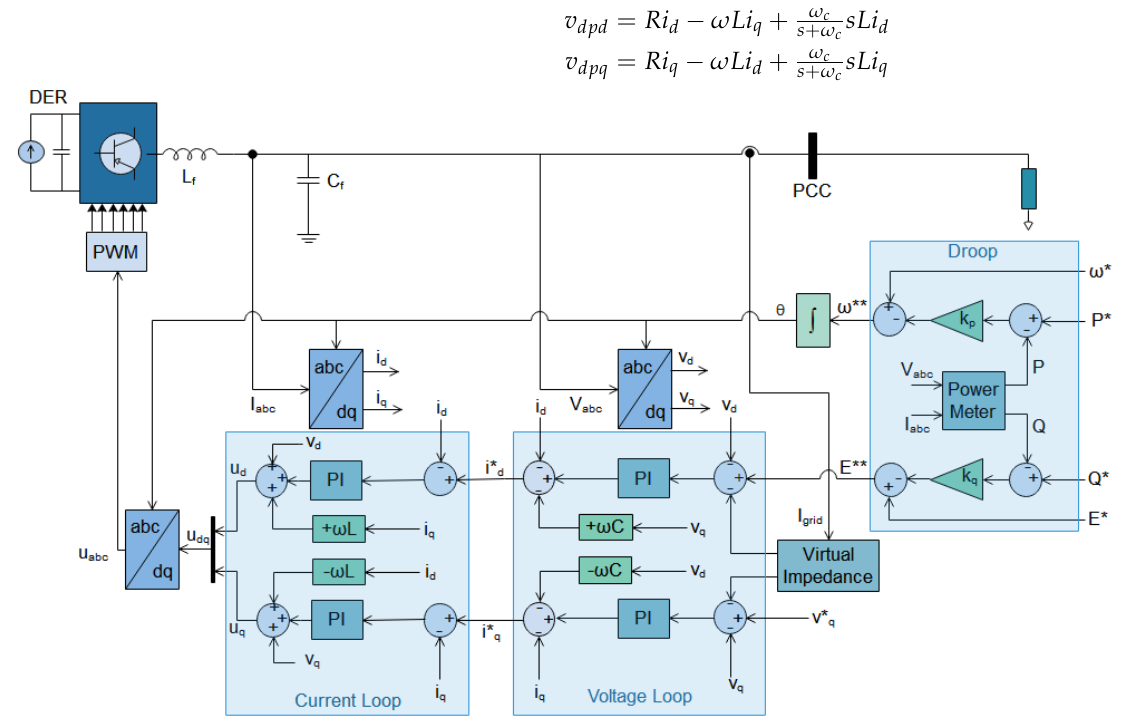
Figure 1. Inverter control with virtual impedance and conventional droop.